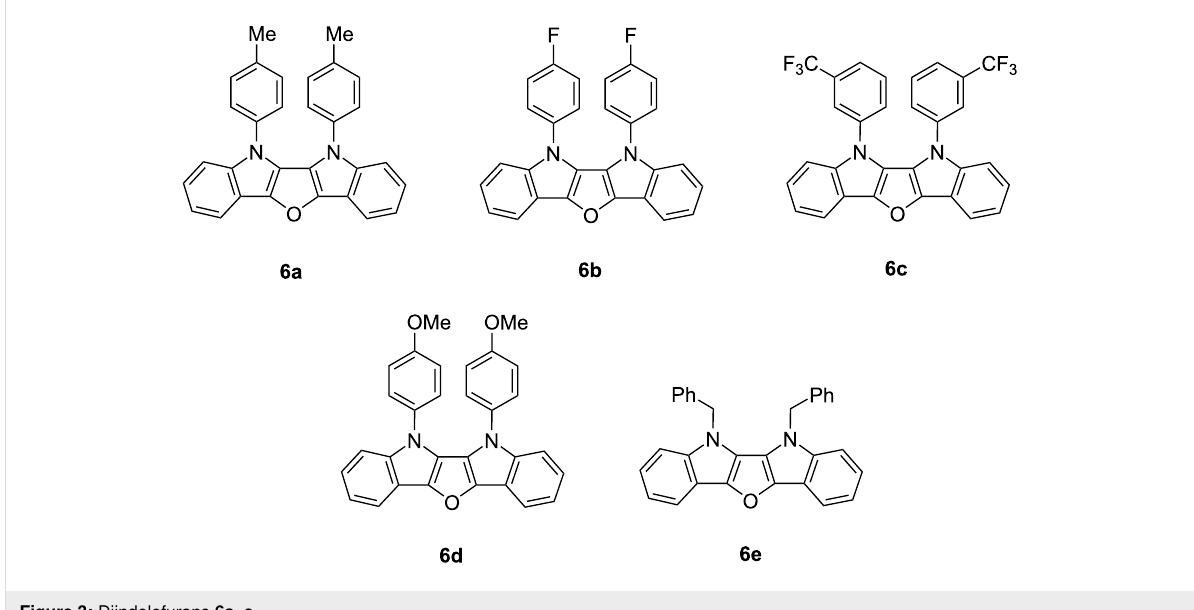
Figure 3: Diindolofurans 6a–e .